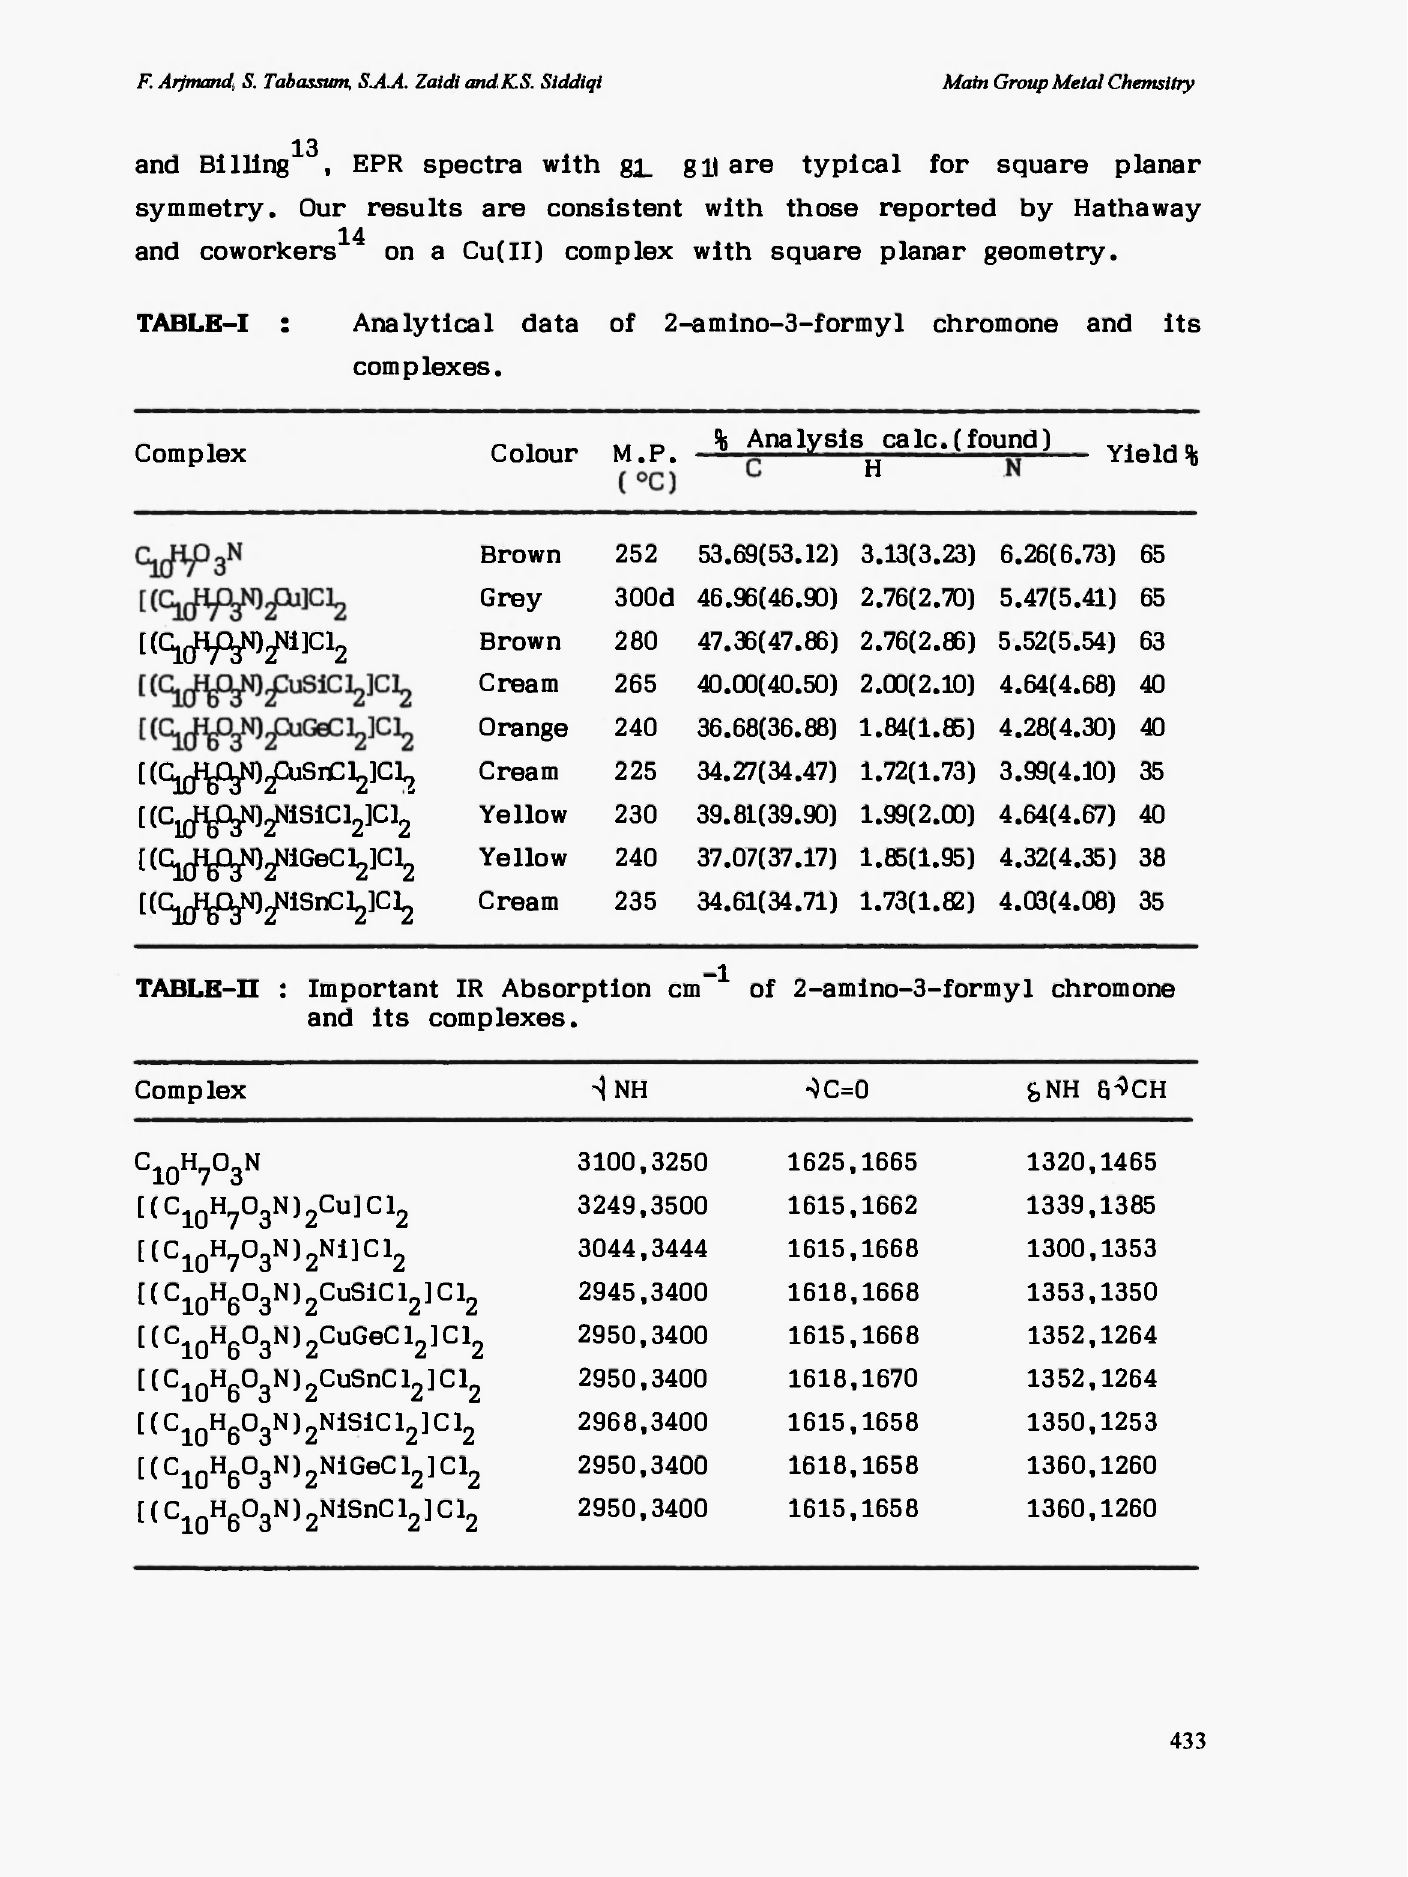
TABLE-Π : Important IR Absorption cm -1 and its complexes.